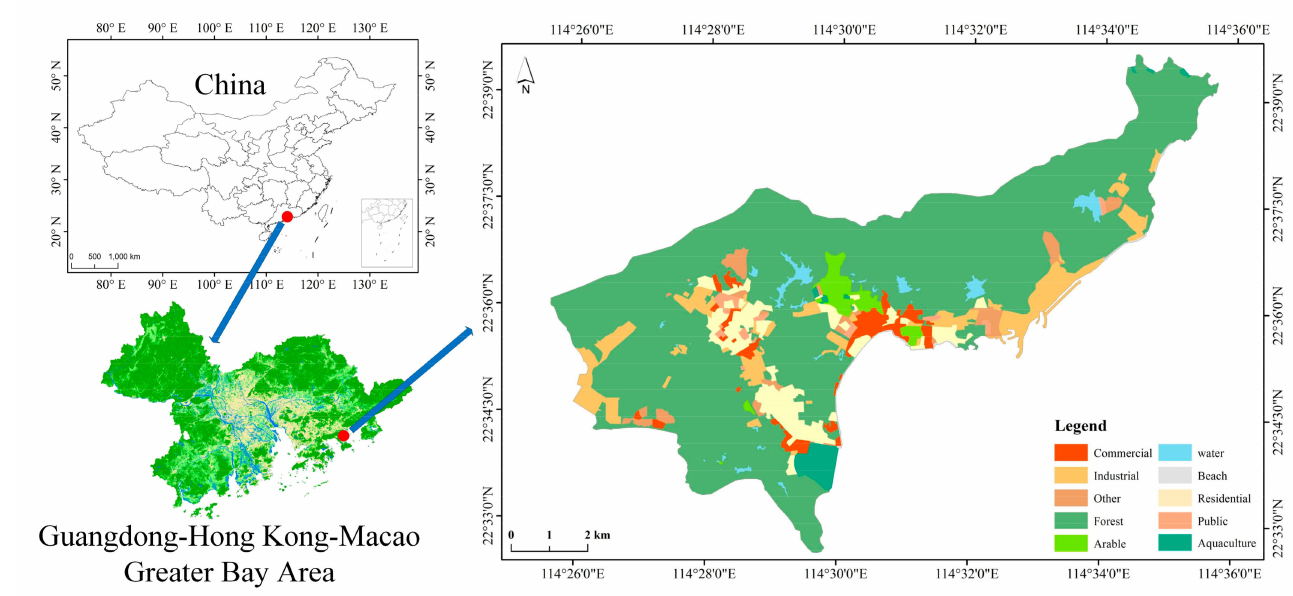
Figure 1. Land-use map of Dapeng Community in 2017 (map to the right), located within the Greater Bay Area (lower left map) of China (upper left map). For modeling purposes, the land-use map is divided into 1878 × 1418 cells, with each cell being 10 × 10 m in size. Color codings show different land-use types as listed in the